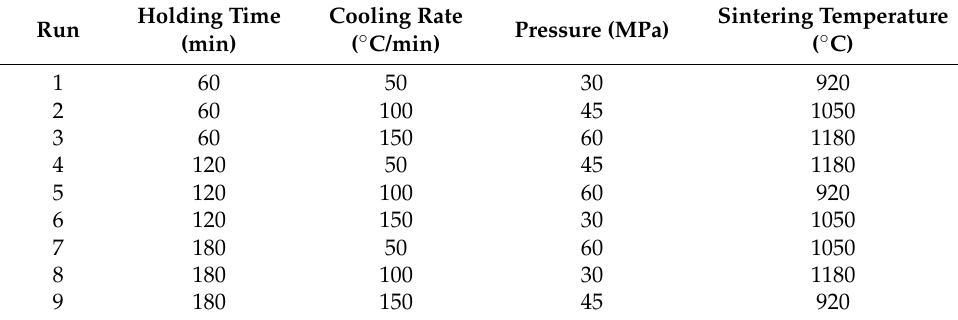
Table 3. Experimental data for the sintering process.